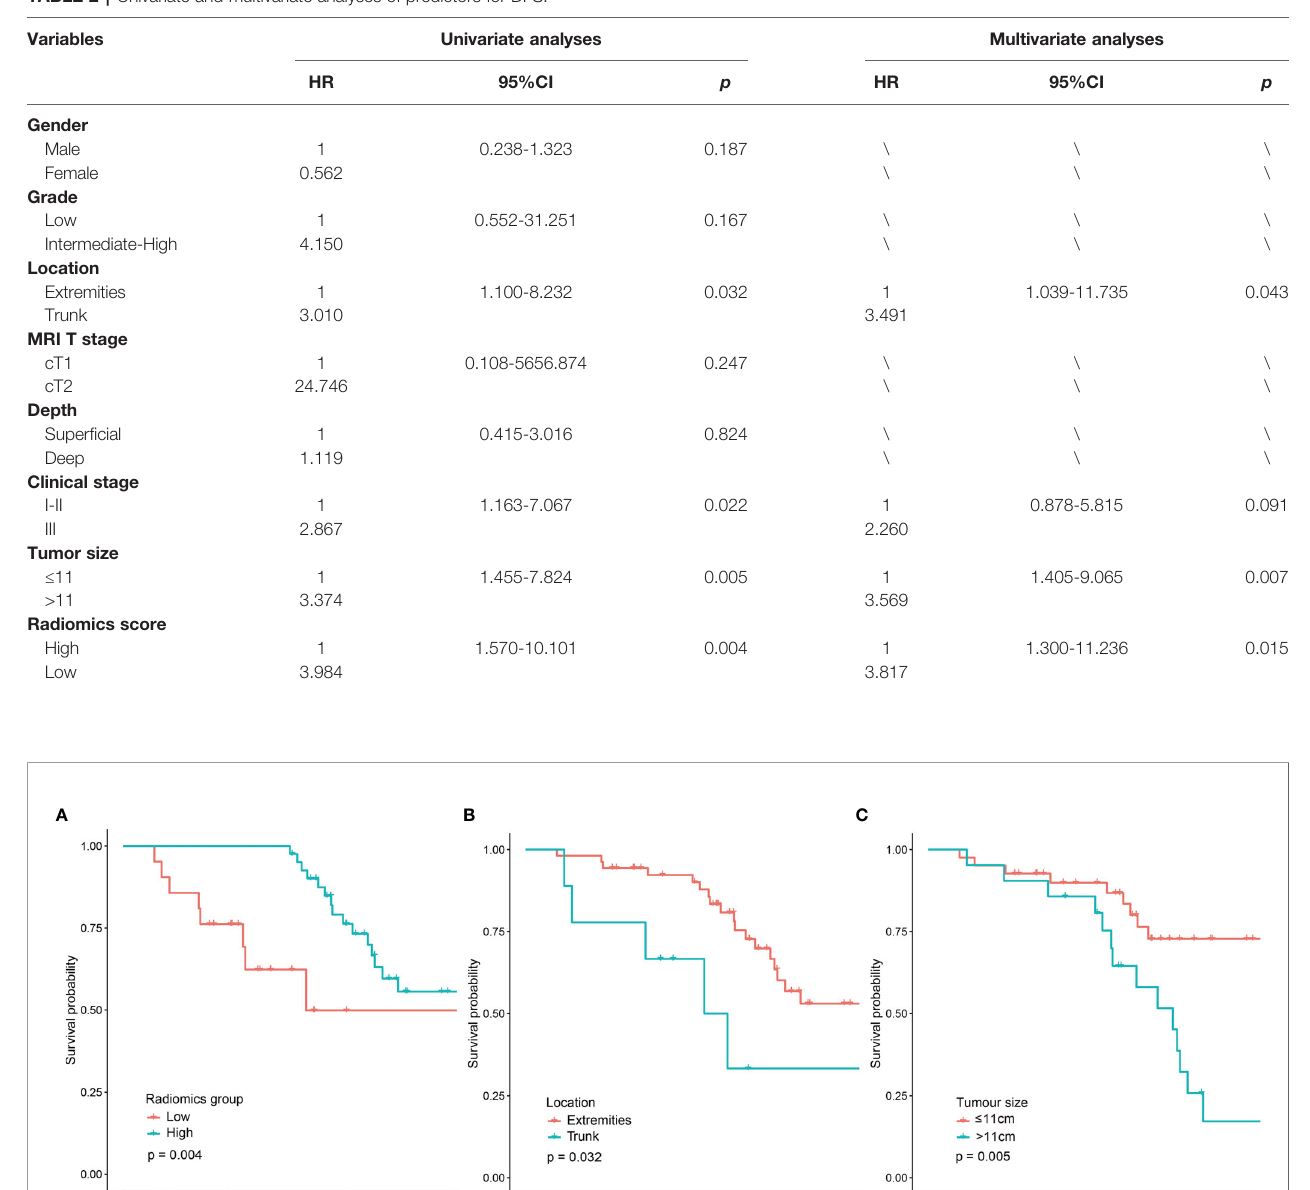
TABLE 2 | Univariate and multivariate analyses of predictors for DFS.